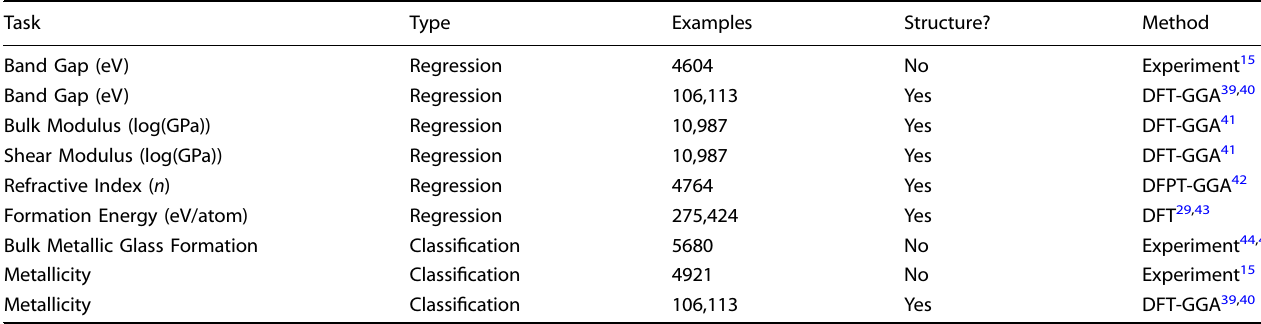
Table 1. The predictive tasks utilized in this study to evaluate the atom vector pooling approach.